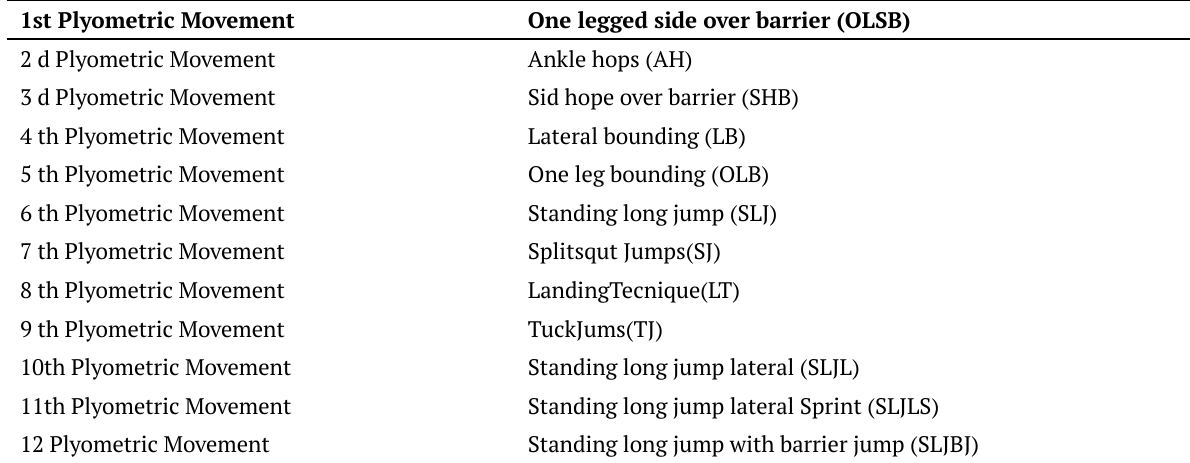
Table 3. Plyometric movements applied to footballers 1st Plyometric Movement